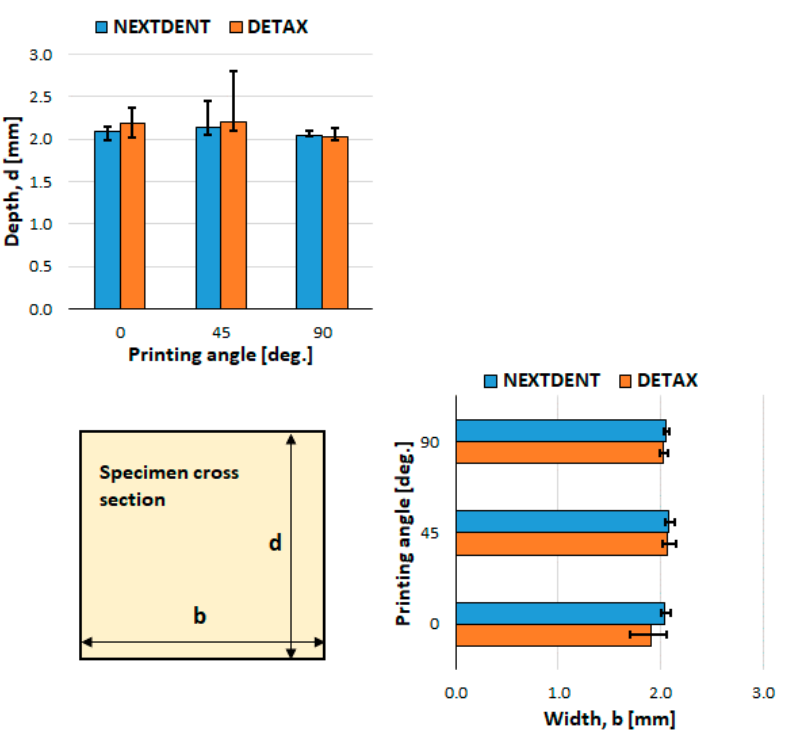
Figure 2. The specimens’ cross section, average and scatter (maximum/minimum measured—designed dimension) of b and d dimensions.